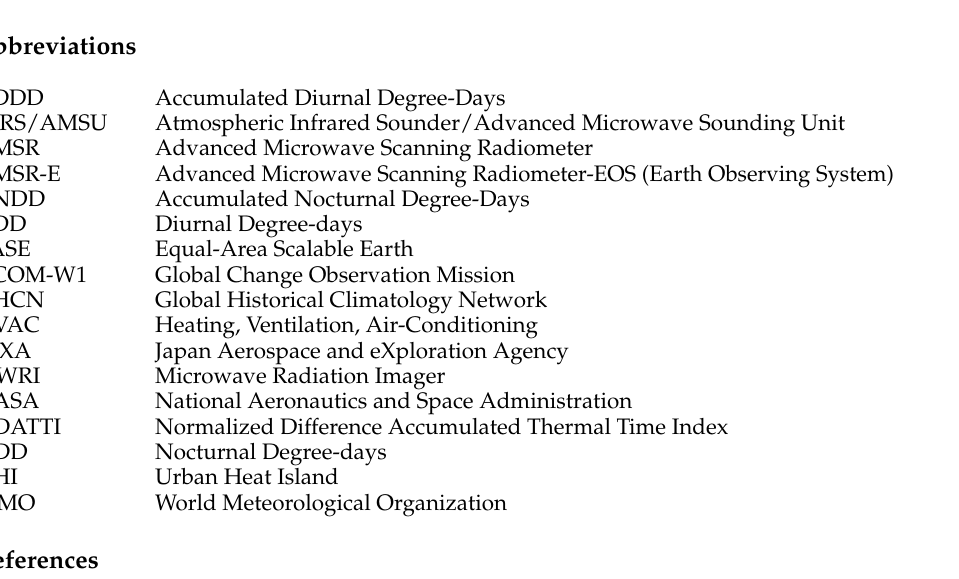
Figure S1: Ecoregions of the Western Hemisphere [1], Table S1: The largest urban agglomerations by the extent in the Western Hemisphere [2], Table S2: Multi-years average accumulated thermal times as estimated by AMSR and GHCN